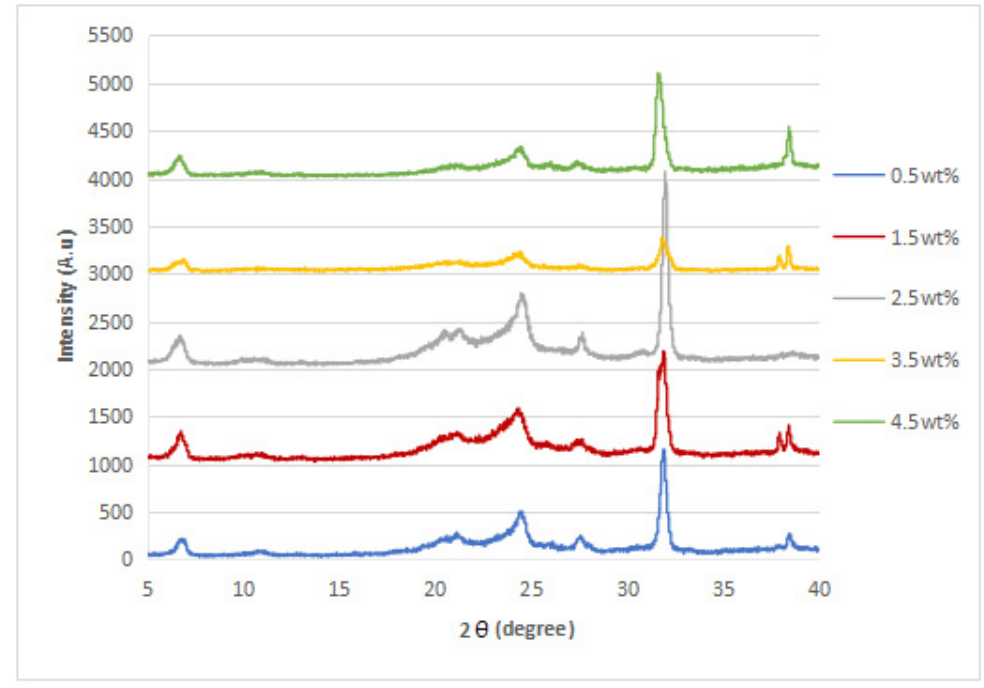
Figure 4. XRD Spectra of Nylon 610 Nanocomposites with Treated Graphite Flakes at 200 °C and − 0.08 MPa.